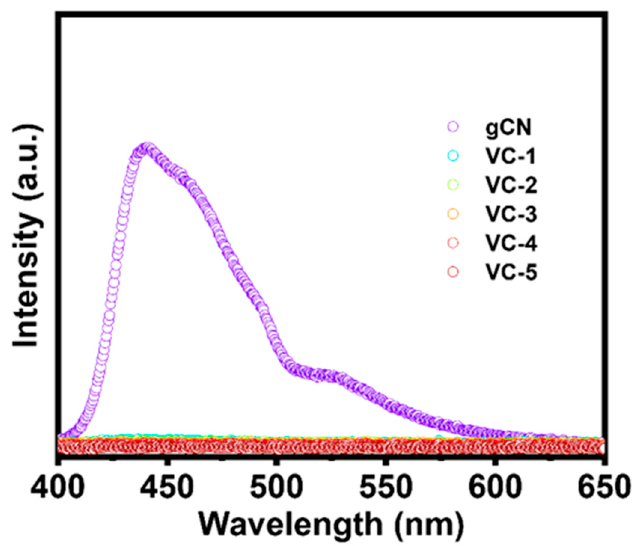
Figure 3. The PL emission spectra of gCN and V/Cu/gCN nanosheets .